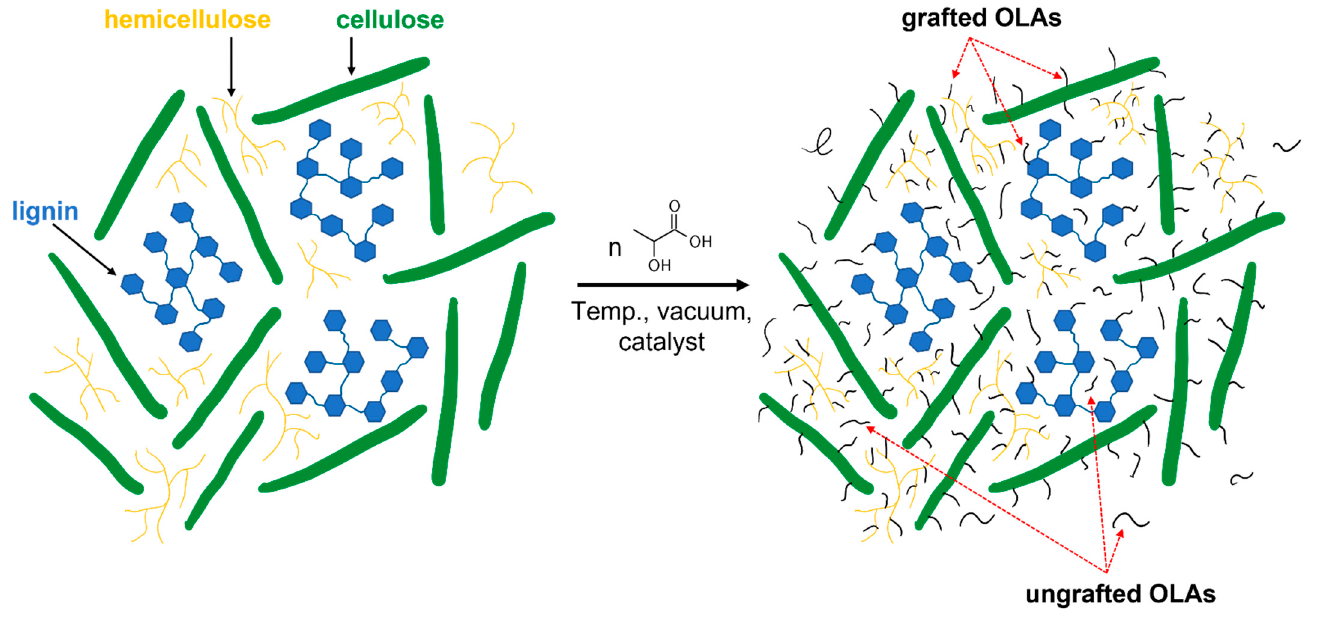
Figure 1. Scheme of chemical modification. Table 2. Modification details.